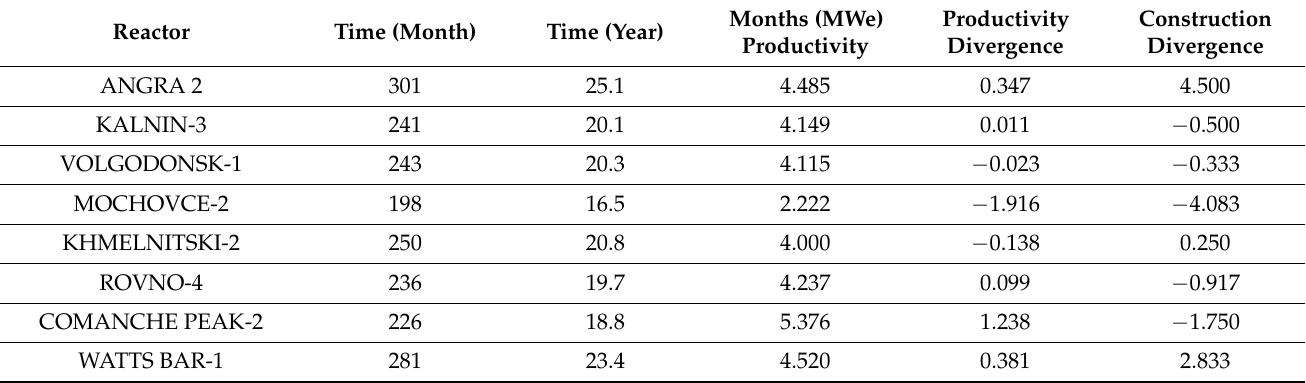
Table 2. Comparative indicators based on productivity. Extended calculation. Source: authors.